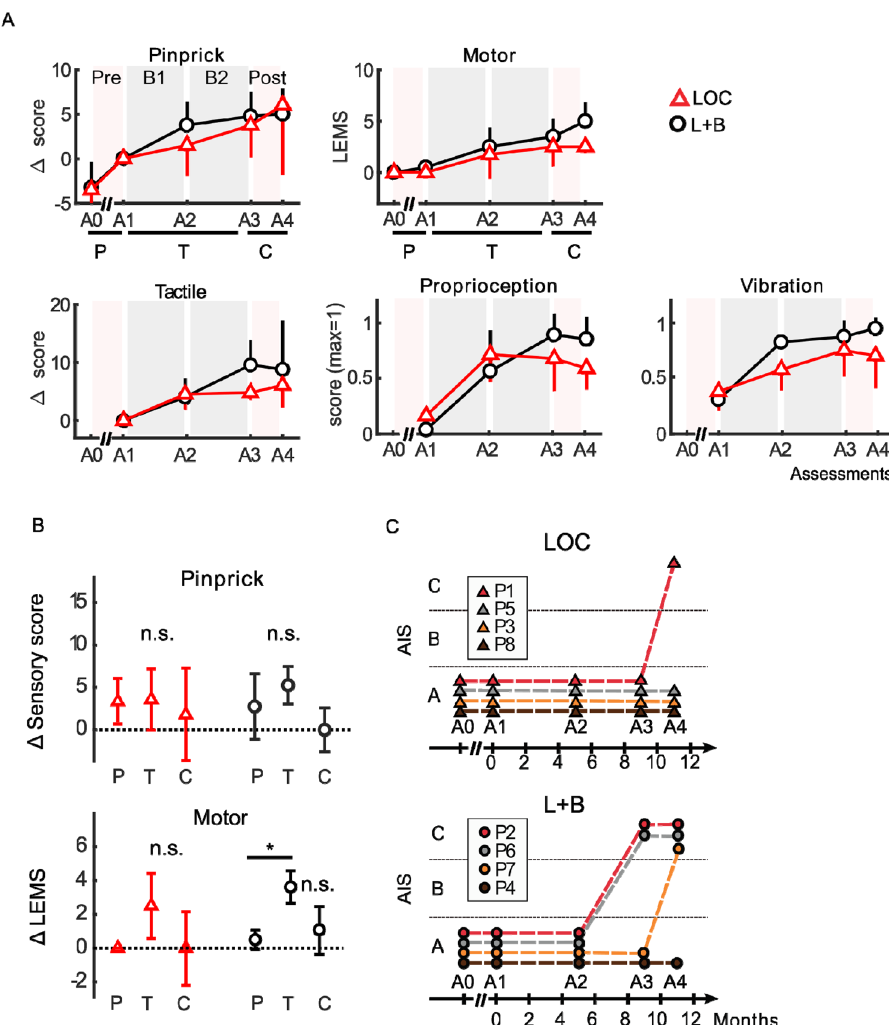
Figure 3. Clinical outcome. ( A ) Mean ± STD clinical scores (n = 4) for the subjects following the locomotion + BMI training (black circle) and the locomotion only protocol (red triangles). Pinprick’s score and tactile score are reported as differences in the baseline assessment at the onset of the protocol (A1); for motor performance, we show the raw lower extremity motor score (LEMS 3 ). We also report the lower limb proprioception score and vibration score (max score = 1). The measurement A0 was done (by a different clinical institution) 1–3 years before the onset of the protocol and consisted of only pinprick and motor measurements. ( B ) Improvement (sensory or LEMS score) measured for participants following the L + B (black circles) or LOC (red triangle) groups for (P)re training (improvement between A0 and A1), (T)raining (improvement between A1 and A3) and (C)arry over (between A3 and A4) (Friedman test, and multiple comparisons with Bonferroni correction, * P < 0.05). ( C ) AIS grades for all study